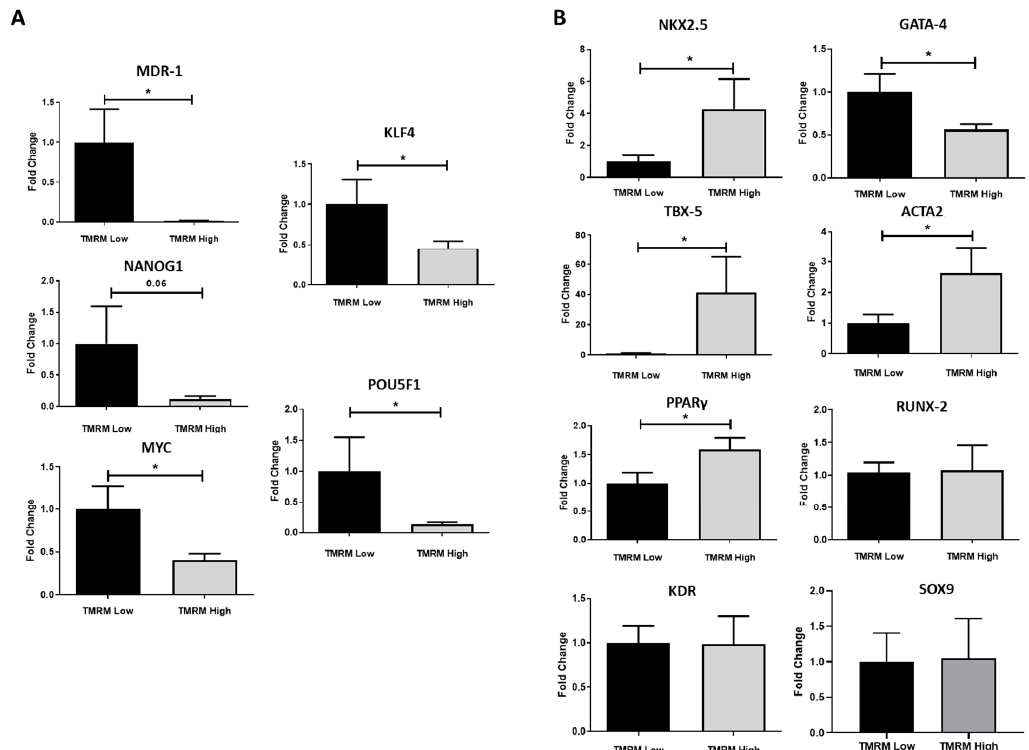
Figure 5. Gene expression of TMRM-low and high cells in basal condition. mRNA expression of markers associated to undifferentiated cells ( A ) and lineage specific cells ( B ) were determined